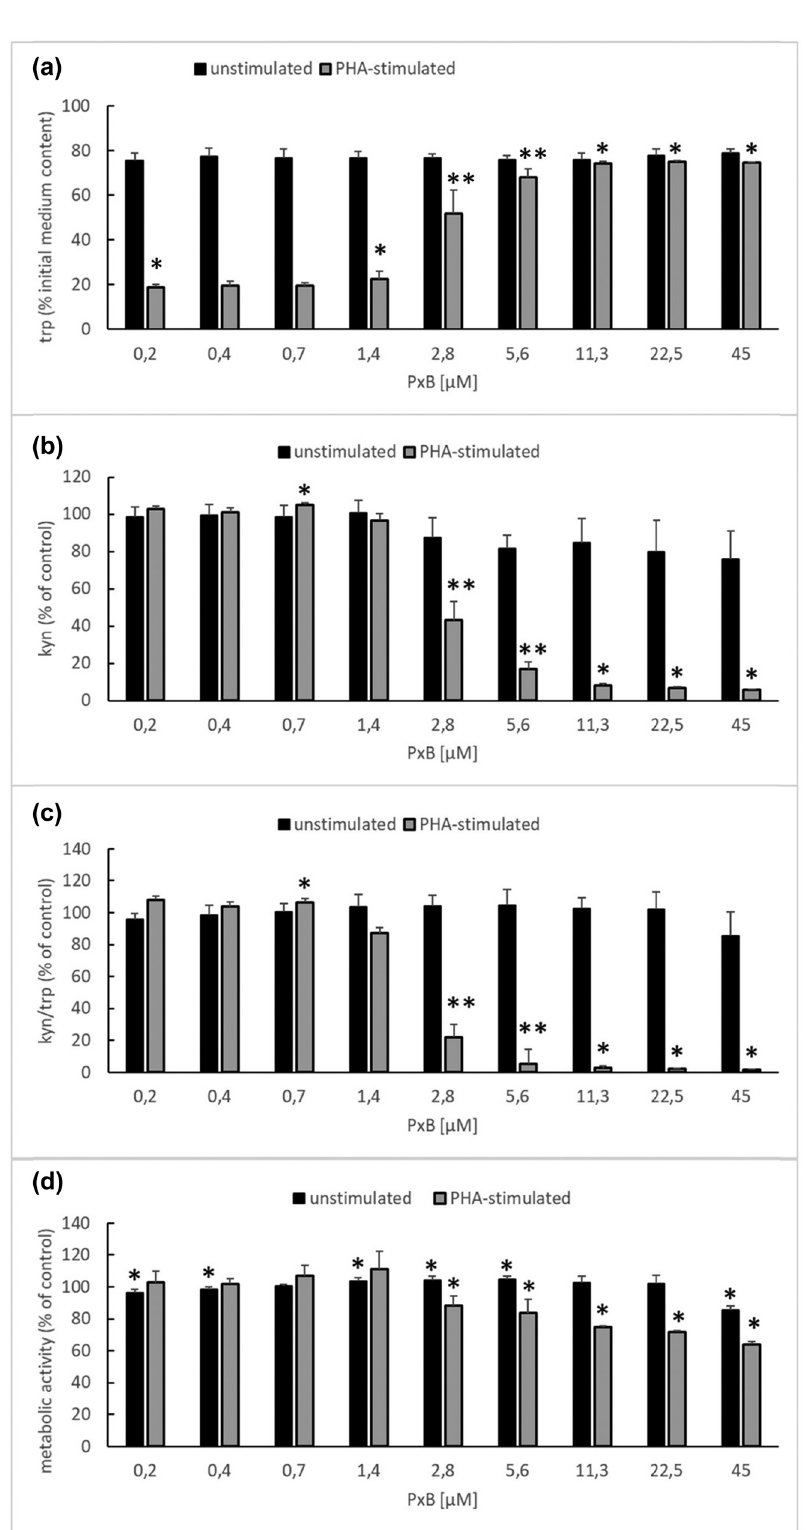
Figure 3: PxB a ff ects tryptophan metabolism. PBMC were either stimulated with phytohemagglutinin ( PHA, 10 µg/ml, black bars ) or unstimulated ( grey bars ) prior to treatment with increasing concentrations of PxB. Concentrations of tryptophan ( a ) and kynurenine ( b ) were measured and expressed as kyn/trp ratio ( c ) . The metabolic activity was determined in cell culture supernatants 48 h after incubation ( d ) . Values are normalized to a vehicle control ( set to 100% ) . Mean values ± SEM are shown ( * p < 0.05, ** p < 0.005 ) . Figure established from data published in Karg et al. [ 4 ]